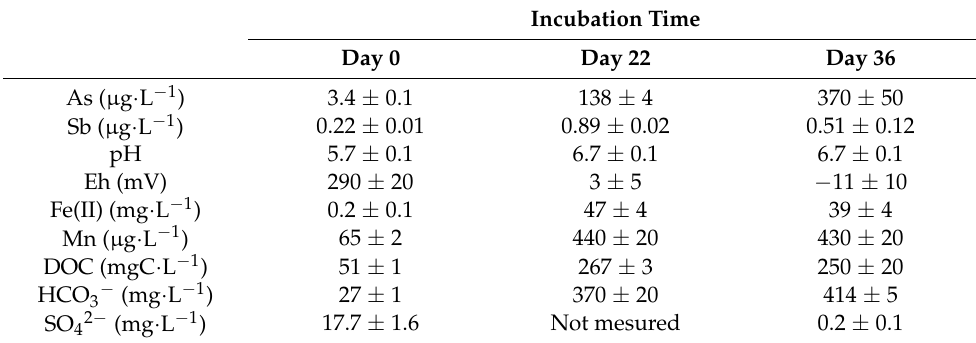
Table 3. Evolution of the soil water characteristics on days 0, 22 and 36. Values are represented as the mean ± standard variation ( n = 3).